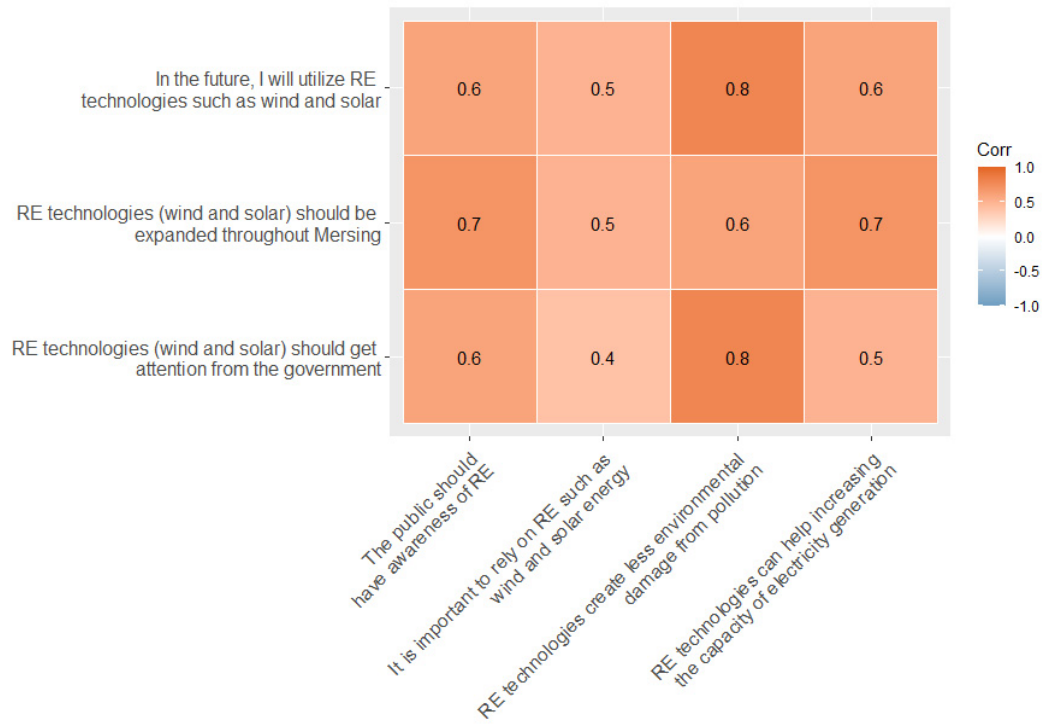
Figure 16. Correlation between items in knowledge and awareness of RE and desire and acceptance of RE.